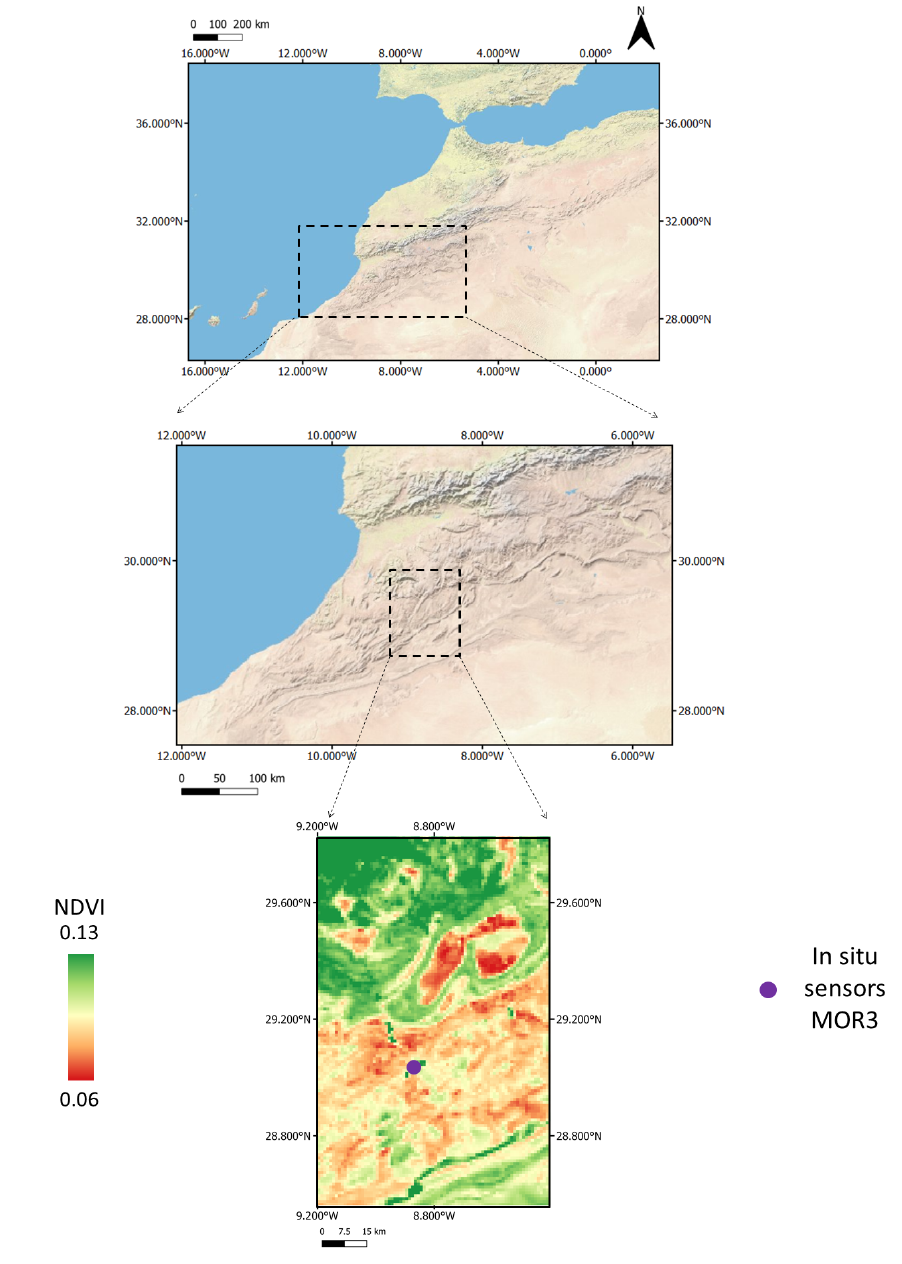
Figure 2. The MOR3 study